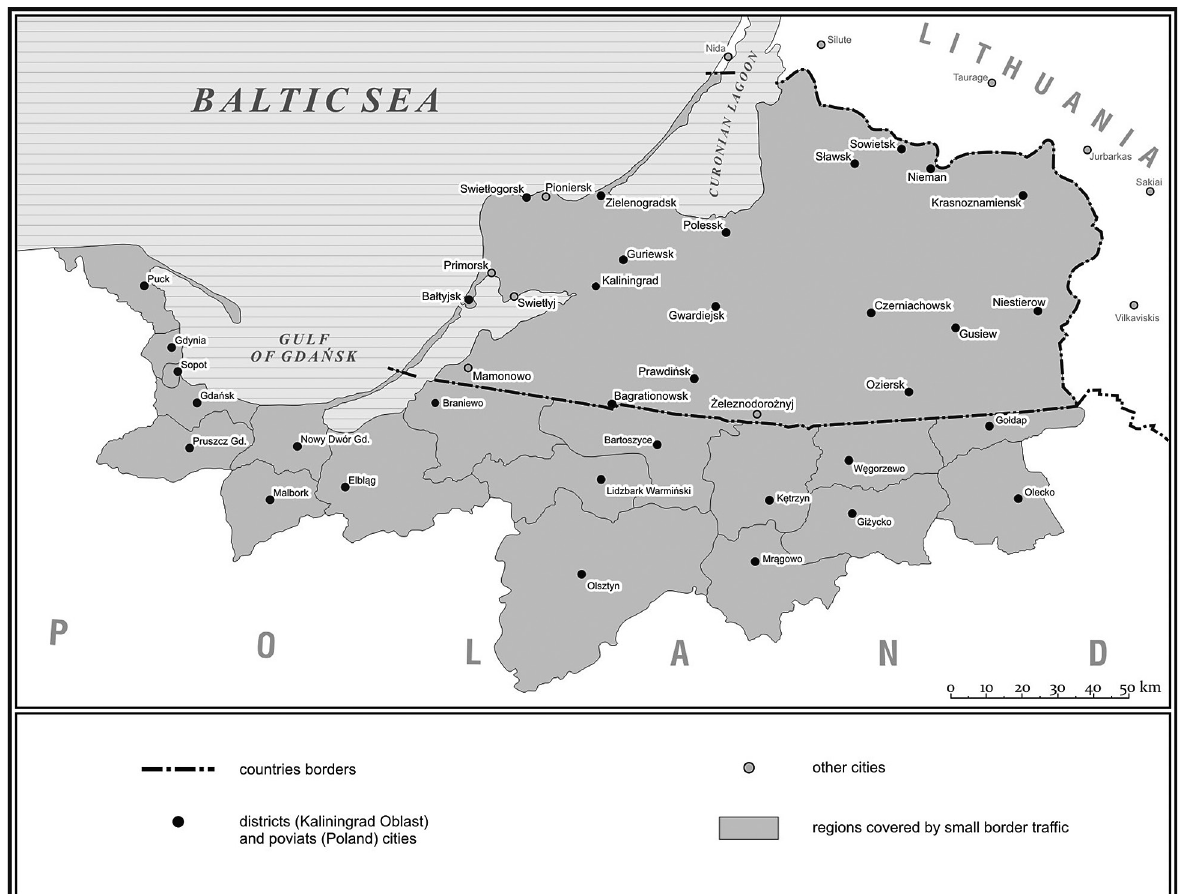
Fig. 1. Kaliningrad Oblast and border regions in Poland covered by the agreement on small border traffic starting on 27 July 2012 Source: own study based on: www.strazgraniczna.pl